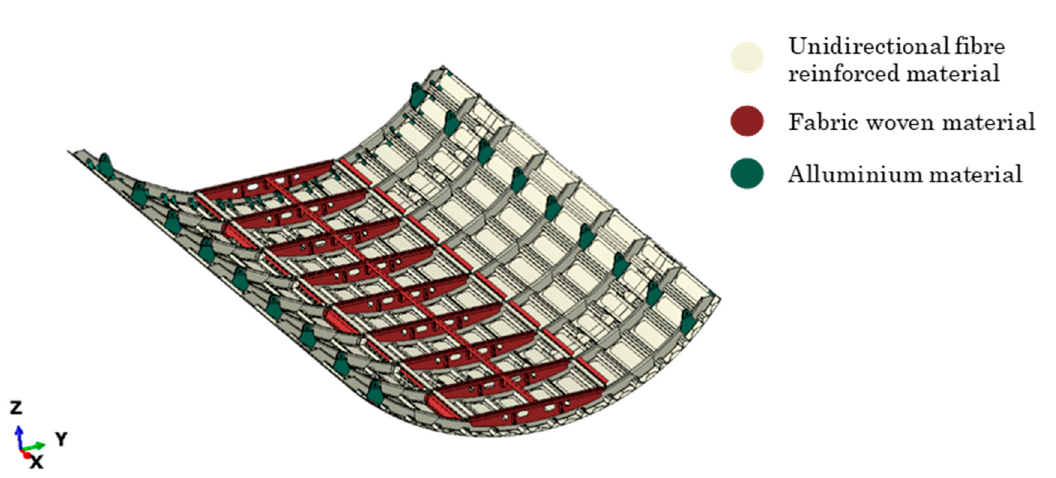
Figure 3. Subsection cargo floor.